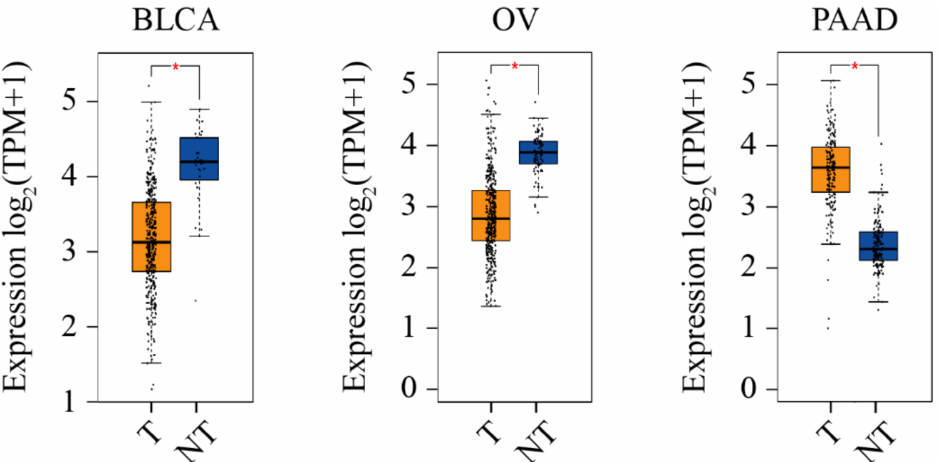
Figure 6. CERT expression level in three cancers. On the GEPIA 2 platform, the CERT expression level is analyzed using expression DIY with ANOVA (Log2FC = 1, q-value cutoff = 0.01) and the matching of TCGA and GTEx data. The * symbol indicates the statistical significance. BLCA, urothelial bladder carcinoma; OV, ovarian cancer; PAAD, pancreatic adenocarcinoma; TPM, transcripts per million. The graph is adapted from GEPIA 2 and edited in Adobe